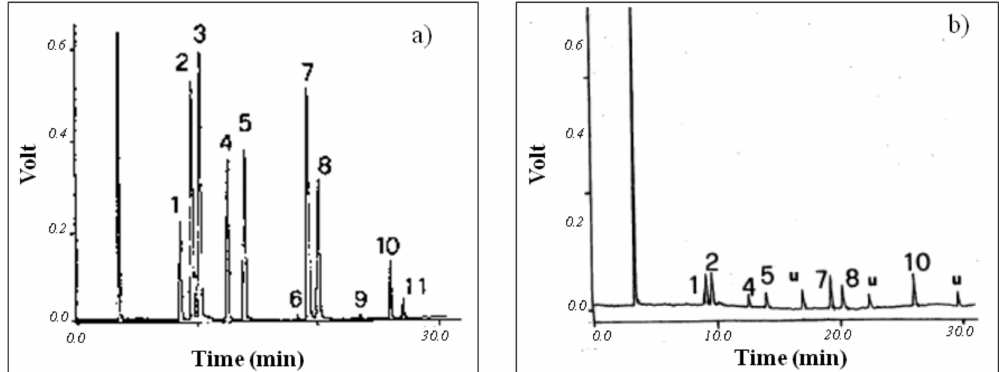
Figure 3. Gas chromatograms of ( a ) a river water sample spiked with a standard solution of halocarbons and ( b ) a real sample (Tiber). For the experimental conditions: see text. Peaks: 1 chloroform (CHCl 3 ); 2 hexachloroethane (CCl 3 CCl 3 ); 3 tetra- chloromethane (CCl 4 ); 4 trichloroethene (CCl 2 CHCl); 5 dichlorobromomethane (CHBrCl 2 ); 6 trichloroethane (CHCl 2 CH 2 Cl); 7 tetrachloroethene (CHCl 2 CH 2 Cl); 8 dibromochloromethane (CHClBr2); 9 chlorobenzene (C 6 H 5 Cl); 10 bromoform (CHBr 3 ); 11 tetrachloroethane (CHCl 2 CHCl 2 ); u